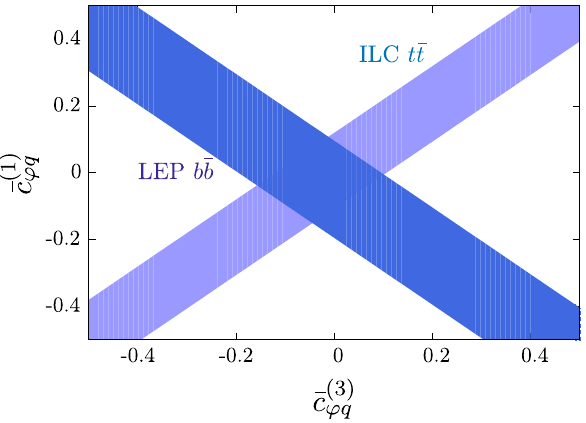
Fig. 11 Allowed 95% confidence regions for the Wilson coefficients ¯ c ( 1 ) ϕ ¯ c ( 3 ) ϕ u and u obtained from combining the information from ILC t asymmetriesandcross-sections( darkblue )andLEP1 b ¯ b